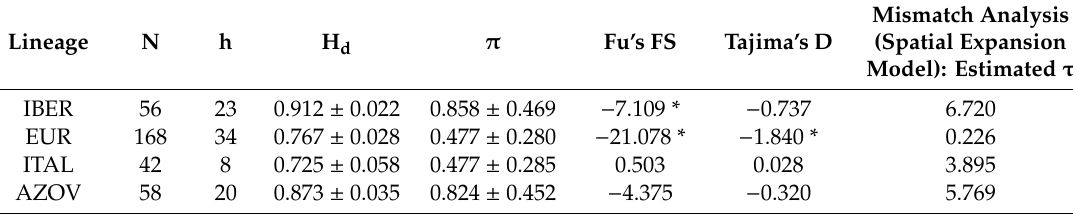
Table 3. Summary of indices of genetic diversity estimated from the COI sequences for Anodonta anatina lineages: sample size (N), number of haplotypes (h), haplotype diversity (H d ), nucleotide diversity ( π ). Values of test of growth within each specie, i.e., the results of Fu’s Fs and Tajima’s D neutrality test. Statistically significant values are followed by an asterisk ( p < 0.05 for Tajima’s D and p < 0.02 for Fu' Fs).